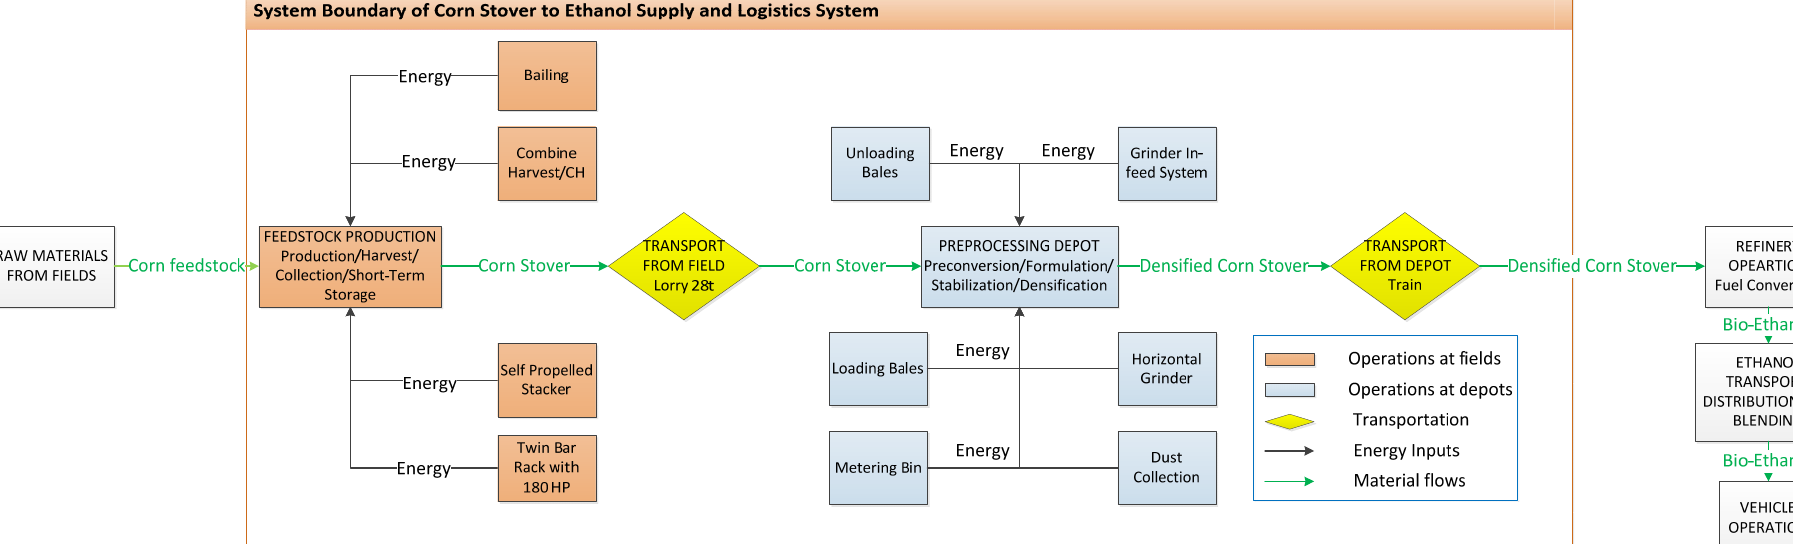
Figure 1. Gate-to-gate system boundary for the corn stover commodity feedstock supply and logistics system within the life cycle of bio-ethanol